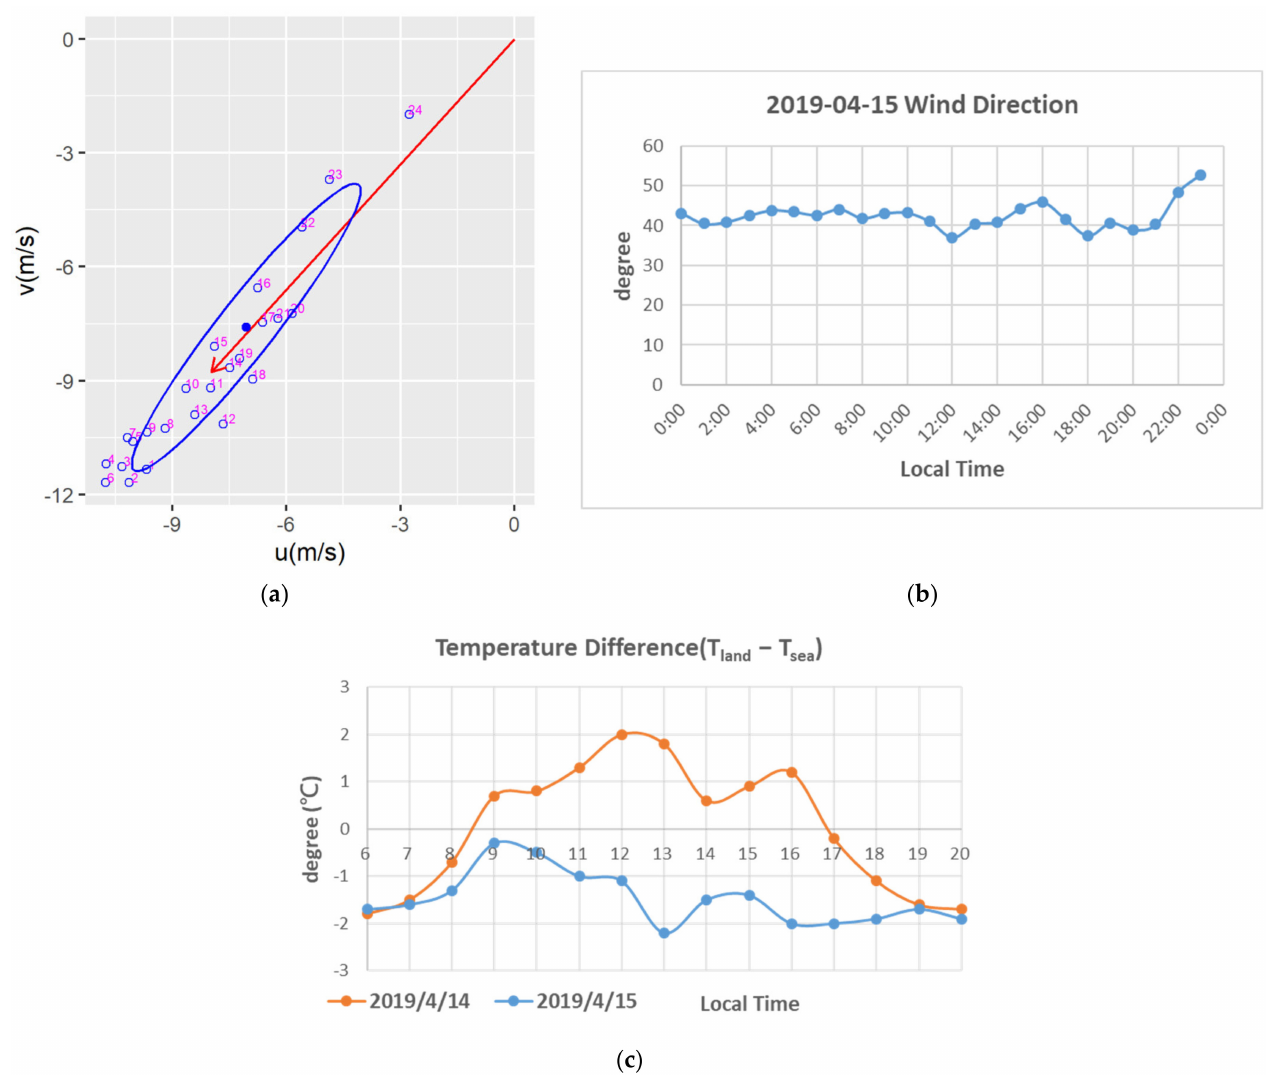
Figure 17. ( a ) The velocity diagram on 15 April 2019. ( b ) Wind direction on 15 April 2019. ( c ) The air temperature difference between the land surface and sea